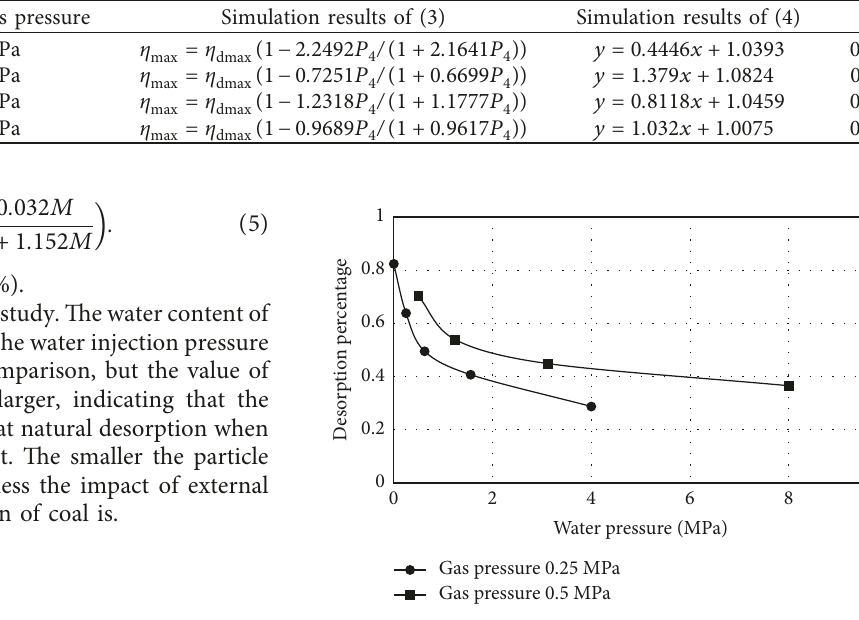
Figure 7: Desorption capacity as a function of water pressure at 90 ° C for coal sample #1.